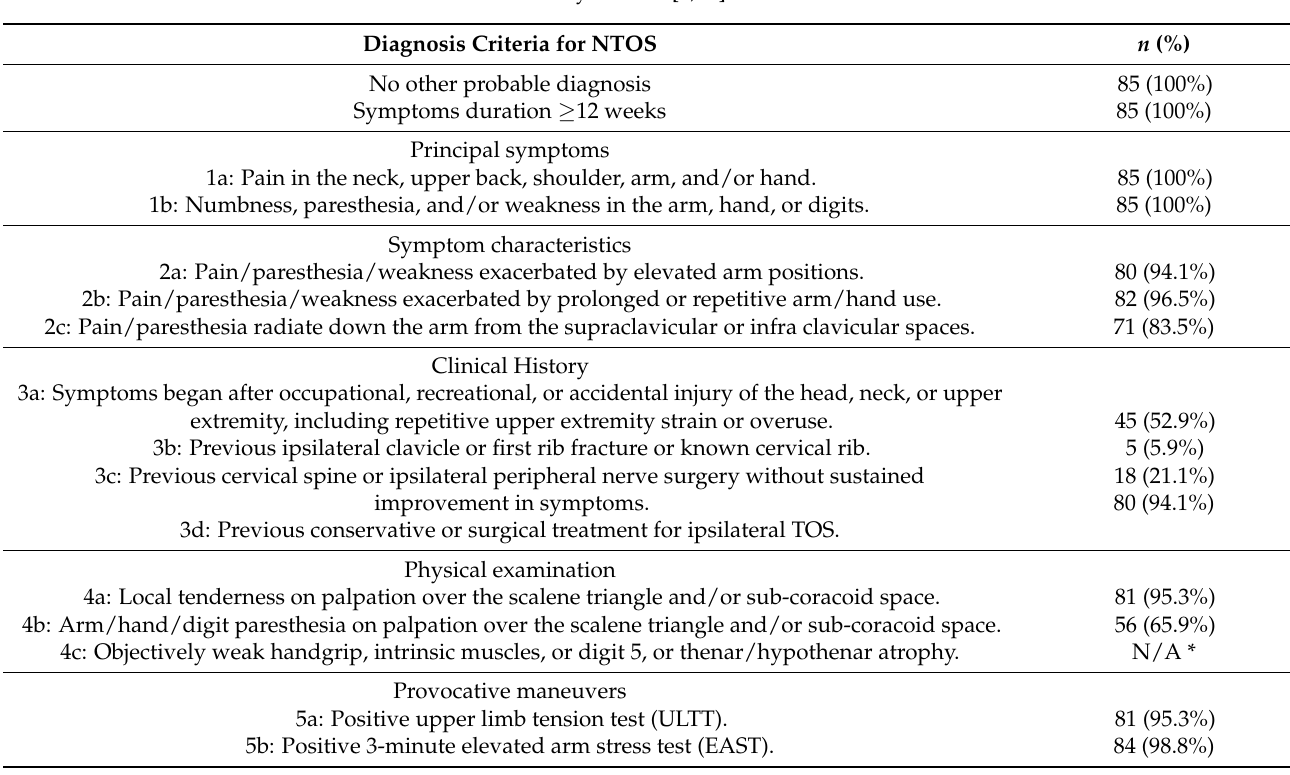
Table 1. Characteristics of the patients with neurogenic thoracic outlet syndrome (NTOS) criteria according to the Consor- tium for Research and Education on thoracic outlet syndrome